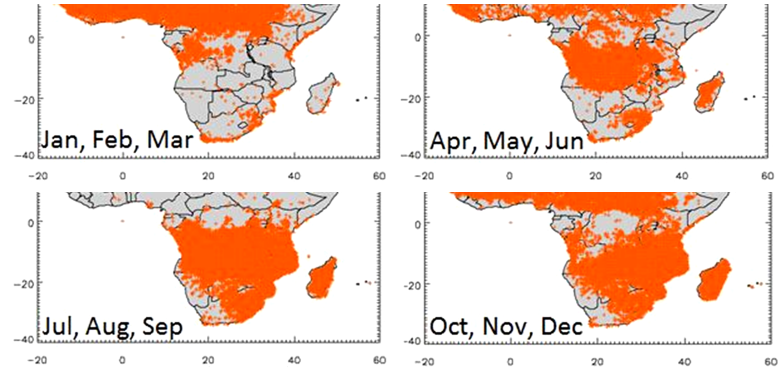
Figure 2. Number of fire hotspots with confidence levels between 80 and 100% averaged in terms of 3 months for the year 2010 in the latitude range between − 40 and 10 ◦ and longitude range between − 20 and 60 ◦